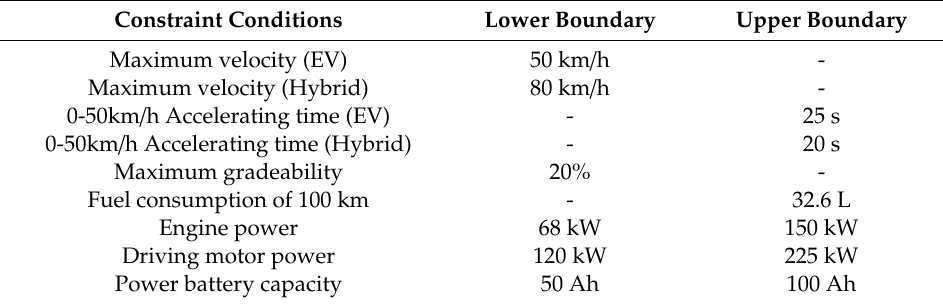
Table 2. Constraint conditions of optimization and matching.